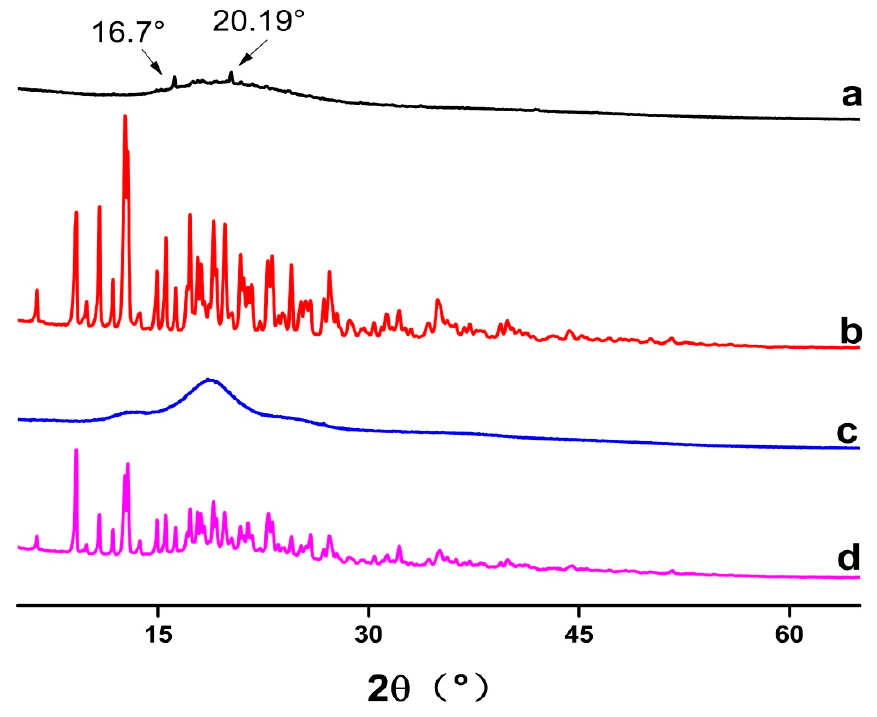
Figure 4. Powder XRD diffractograms of ( a ) Forsythia suspensa leaf extract (FSE), ( b ) β -CD, ( c ) β -CD-assisted extract of Forsythia suspensa leaves (FSE- β -CD) and (d) β -CD with Forsythia suspensa assisted extract of Forsythia suspensa leaves (FSE- β -CD) and ( d ) β -CD with Forsythia suspensa leaf leaf extract 1:1 physical mixture (FSE/ β -CD PM). extract 1:1 physical mixture (FSE/ β -CD